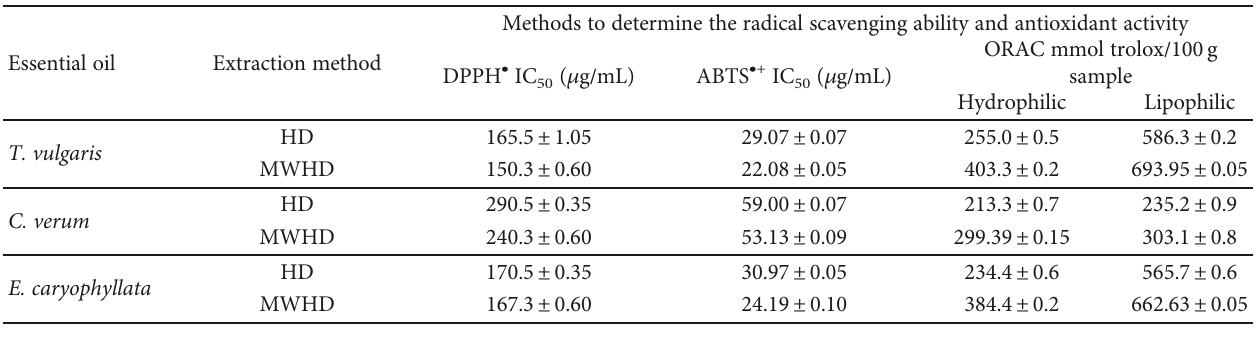
Table 3: Radical scavenging ability and antioxidant capacity of extracted EO by the HD and MWHD methods analyzed by DPPH, ABTS, and ORAC.